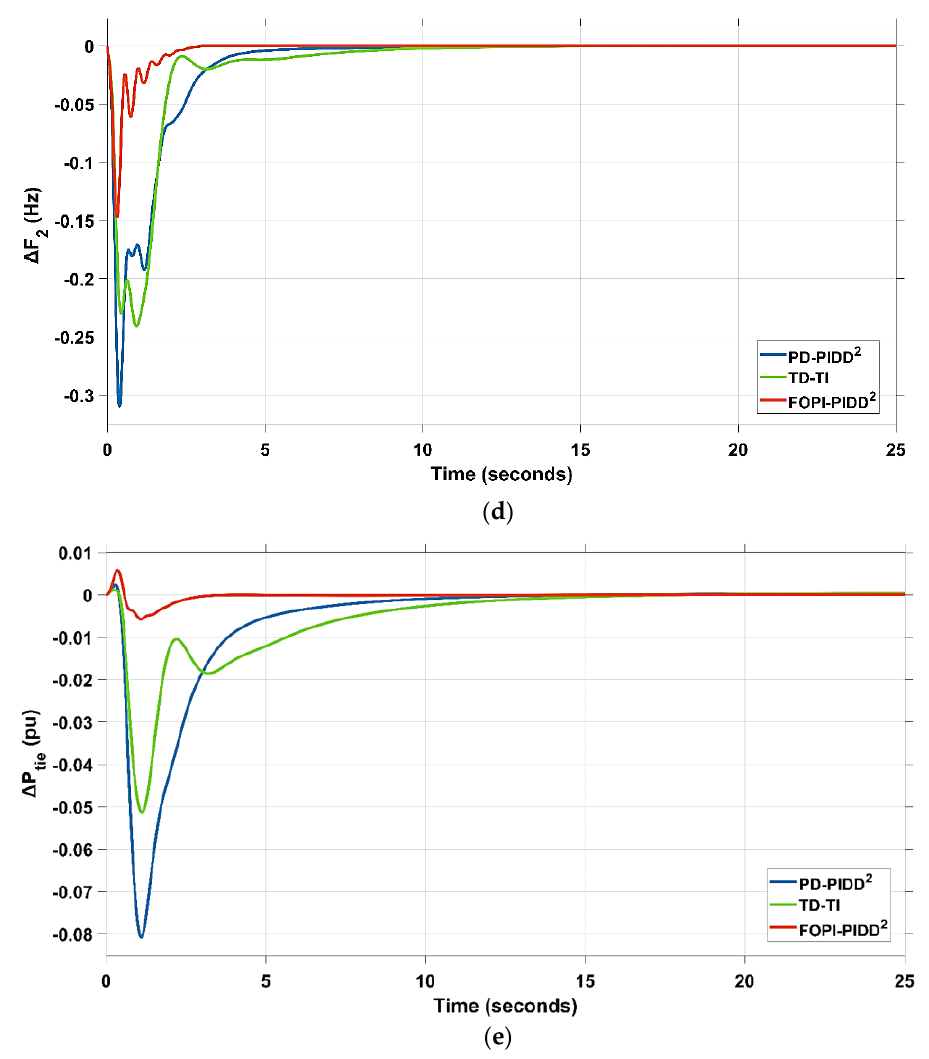
Figure 21. Comparison of PD–PIDD 2 , TD–TI, and FOPI–PIDD 2 optimized by DO algorithm